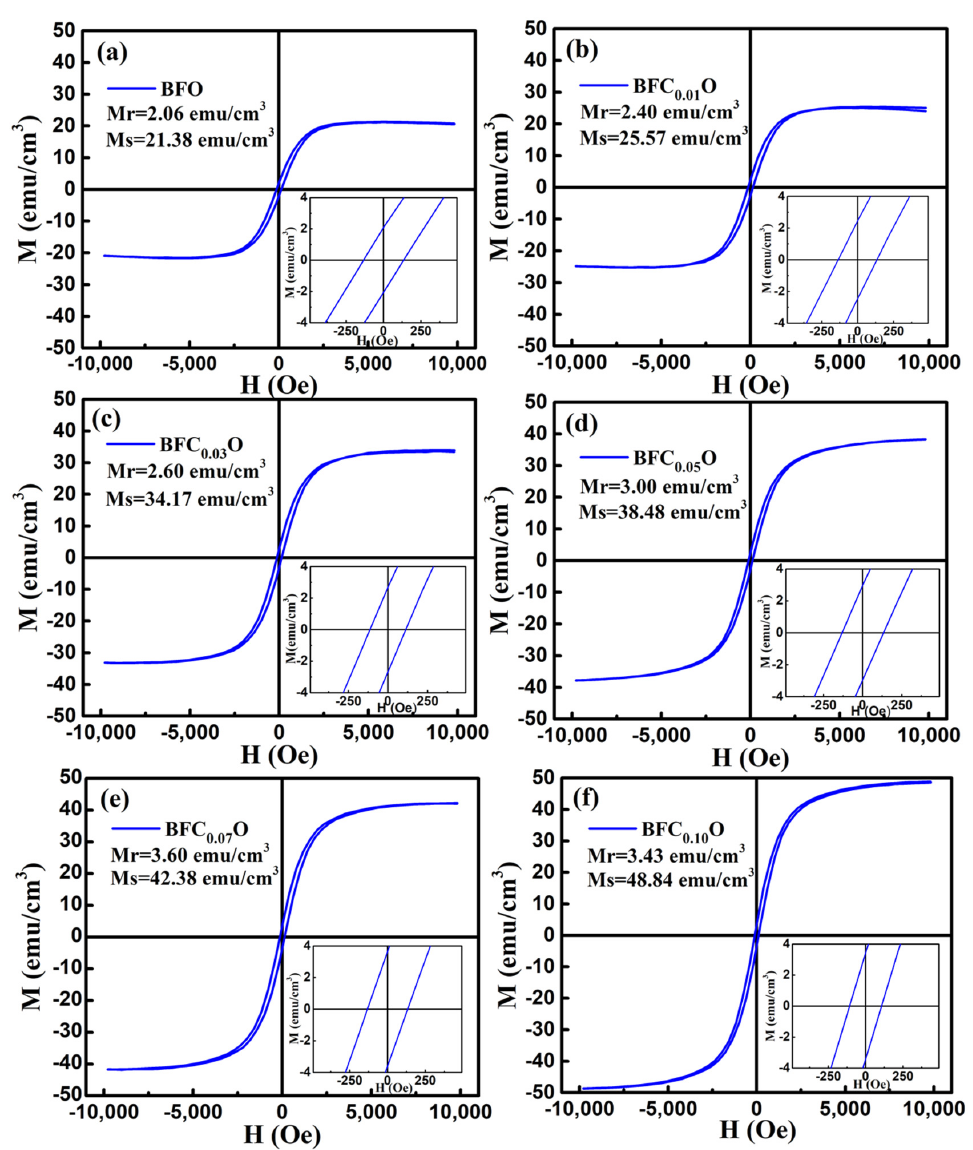
Figure 9. The magnetic hysteresis (M–H) loops for ( a ) BFO, ( b ) BFC 0.01 O, ( c ) BFC 0.03 O, ( d ) BFC 0.05 O, ( e ) BFC 0.07 O and ( f ) BFC 0.10 O thin film at room temperature.